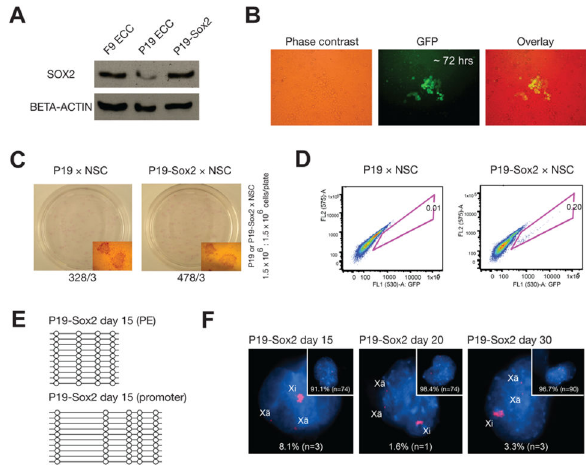
Figure 3. Low levels of Sox2 are responsible for the low reprogramming potential of P19 ECCs. ( A ) After